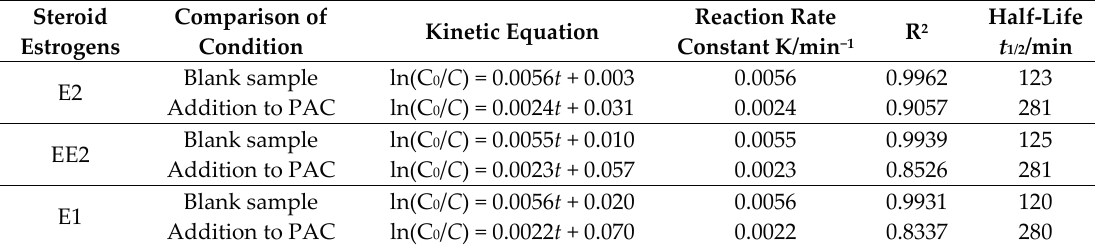
Figure 8. Mineralization of SEs indicated by TOC in KMnO 4 /ultrasound process. Table 7. Parameters of degradation kinetic model of SEs in the presence of Al 3+